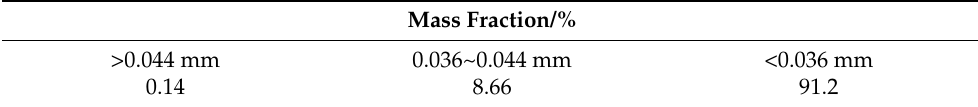
Table 2. Particle size distribution of